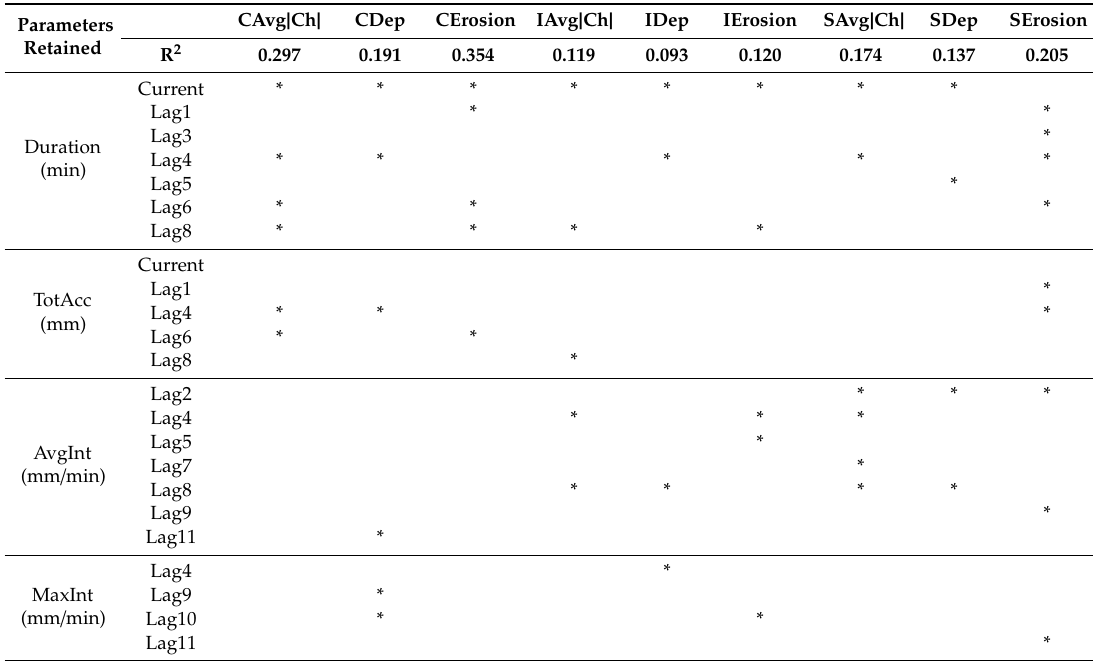
Table 4. Precipitation parameters retained (indicated by *) in Ordinary Least Squares regression models of erosion variables (dependent variables) using lagged precipitation parameters (independent variables). C, channel; I, interfluve; S, sidewall. Each column represents a di ff erent model. CAvg | Ch | CDep CErosion IAvg | Ch | IDep IErosion SAvg | Ch Parameters Retained